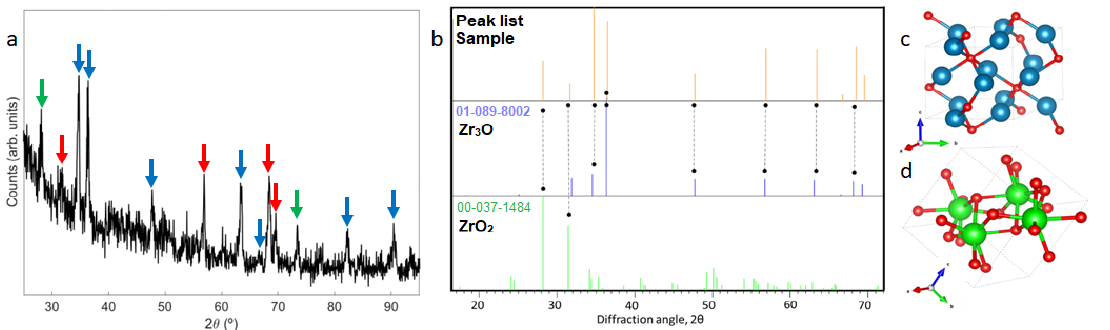
Figure 3. ( a ) XRD diffraction pattern; arrows mark the different phases found (green ones are for the monoclinic ZrO 2 phase, blue ones are for the hexagonal Zr 3 O phase and red ones are for peaks related to both phases). ( b ) Comparison of the peaks obtained (upper) to those listed in the JCPDS cards for the corresponding phases: Zr 3 O (middle) and ZrO 2 (lower). ( c ) Crystal structure of the Zr 3 O phase (O: red; Zr: blue). ( d ) Crystal structure of the ZrO 2 phase (O: red; Zr: green).